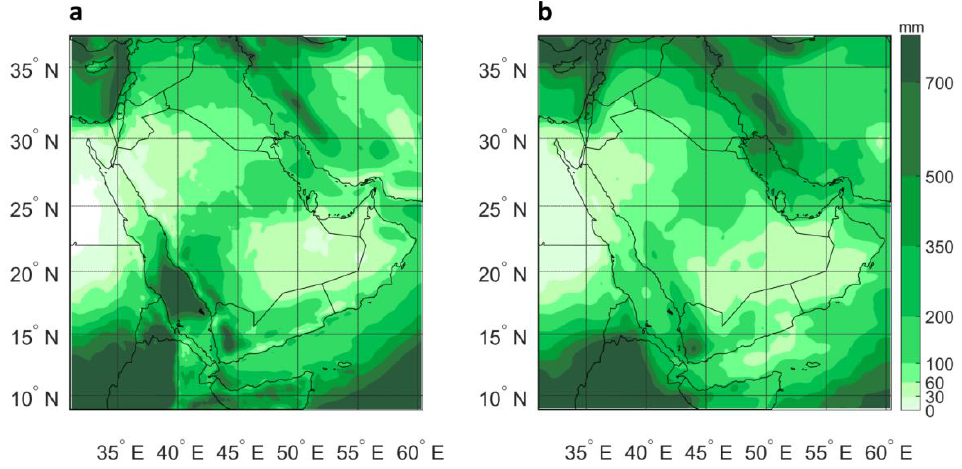
Figure 2. Mean annual accumulated precipitation of ( a ) the model output and ( b ) the IMERG product for the years 2001-2015.